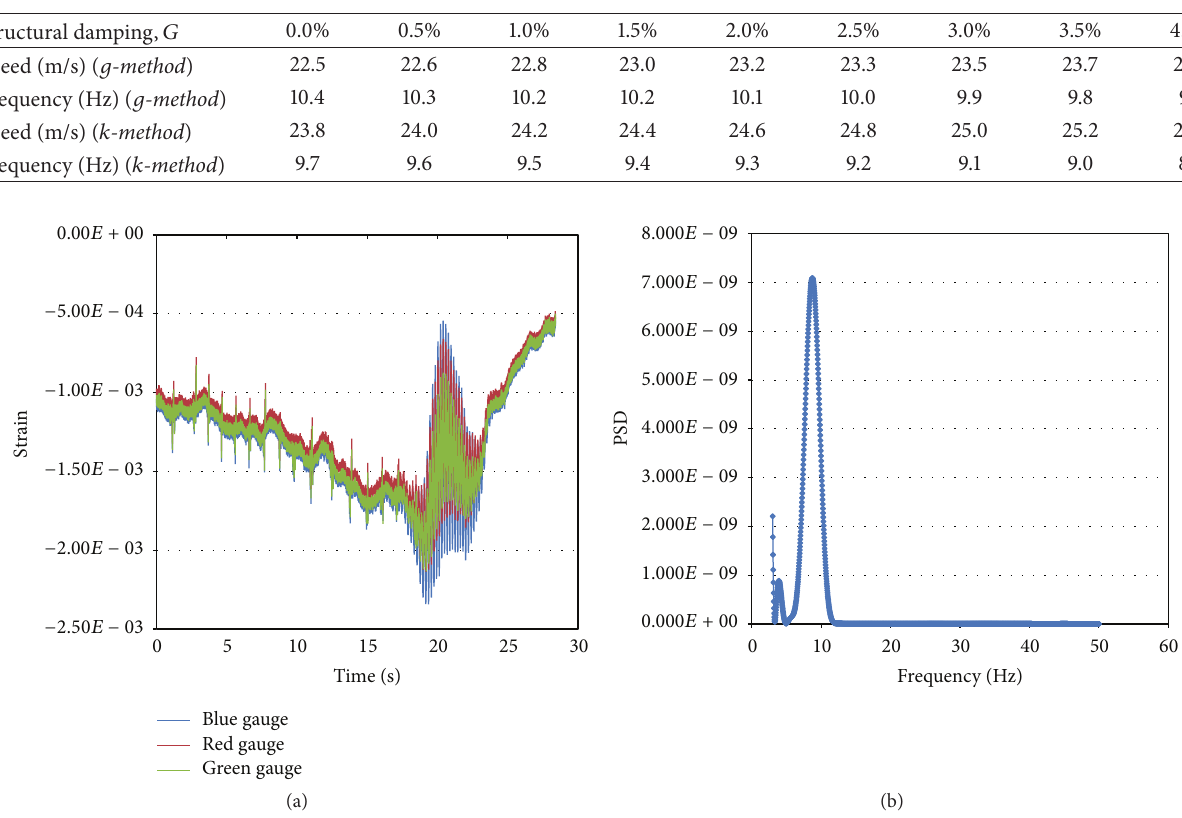
Figure 5: (a) Strain-time and (b) PSD graph of the rectangular plate test item during the wind tunnel test.